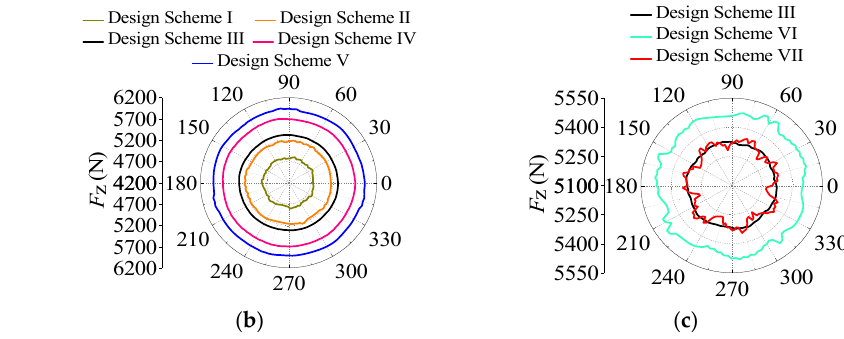
Figure 16. Trajectory distribution of the axial force under 1.0 Q des conditions: ( a ) no deviation; ( b ) deviation of a single blade; and ( c ) deviations of two blades.